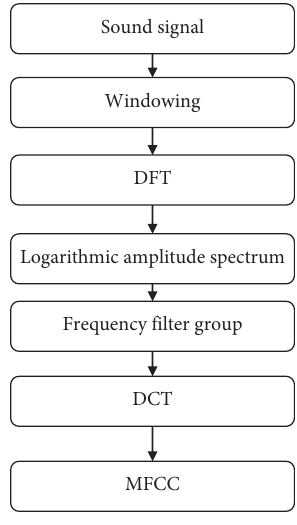
Figure 2: Extracting MFCC from audio.